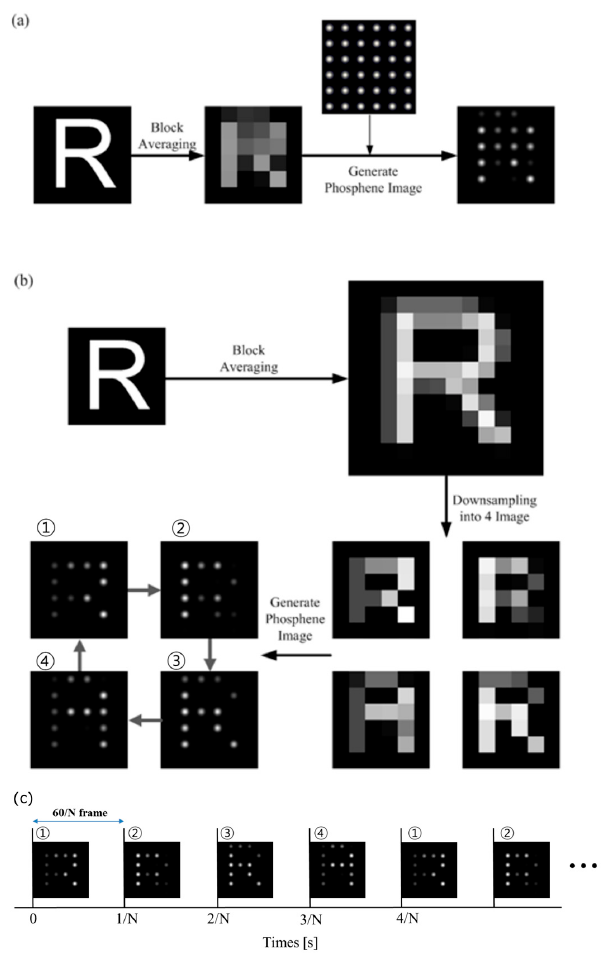
Figure 1. The stimulating image generation procedures. ( a ) The static pixelization method: the image is sampled with the same spatial resolution of the stimulating electrodes for static stimulation; ( b ) The spatiotemporal pixelization method: the original image was sampled at a spatial resolution that was four times higher than that of the static pixelization and sub-sampled into four different lower resolution images; ( c ) The presenting way of the spatiotemporal pixelization method.